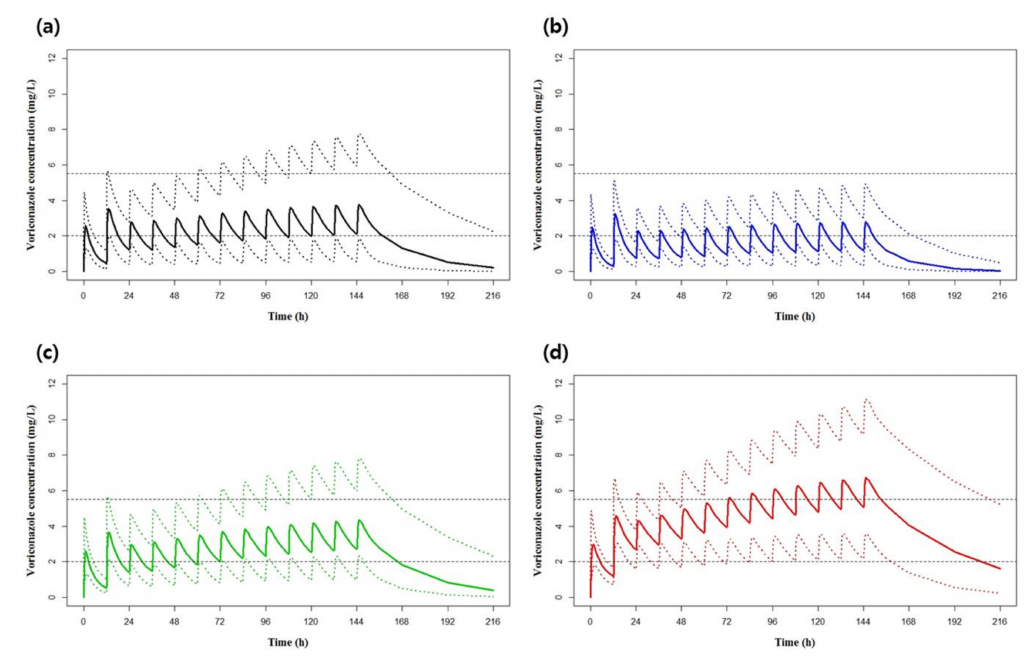
Figure 3. Predicted median concentration–time profile over the first 7 days of treatment of ( a ) total 10,000 simulated patients or patients with ( b ) CYP2C19 EM phenotype, ( c ) IM phenotype, and ( d ) PM phenotype. Standard oral dosing (400 mg twice daily for two doses followed by 200 mg twice daily) was used. The solid lines represent the median, with the dotted lines representing the 10th and 90th percentiles. The dashed lines represent the therapeutic target range for voriconazole trough plasma concentration of 2.0 to 5.5